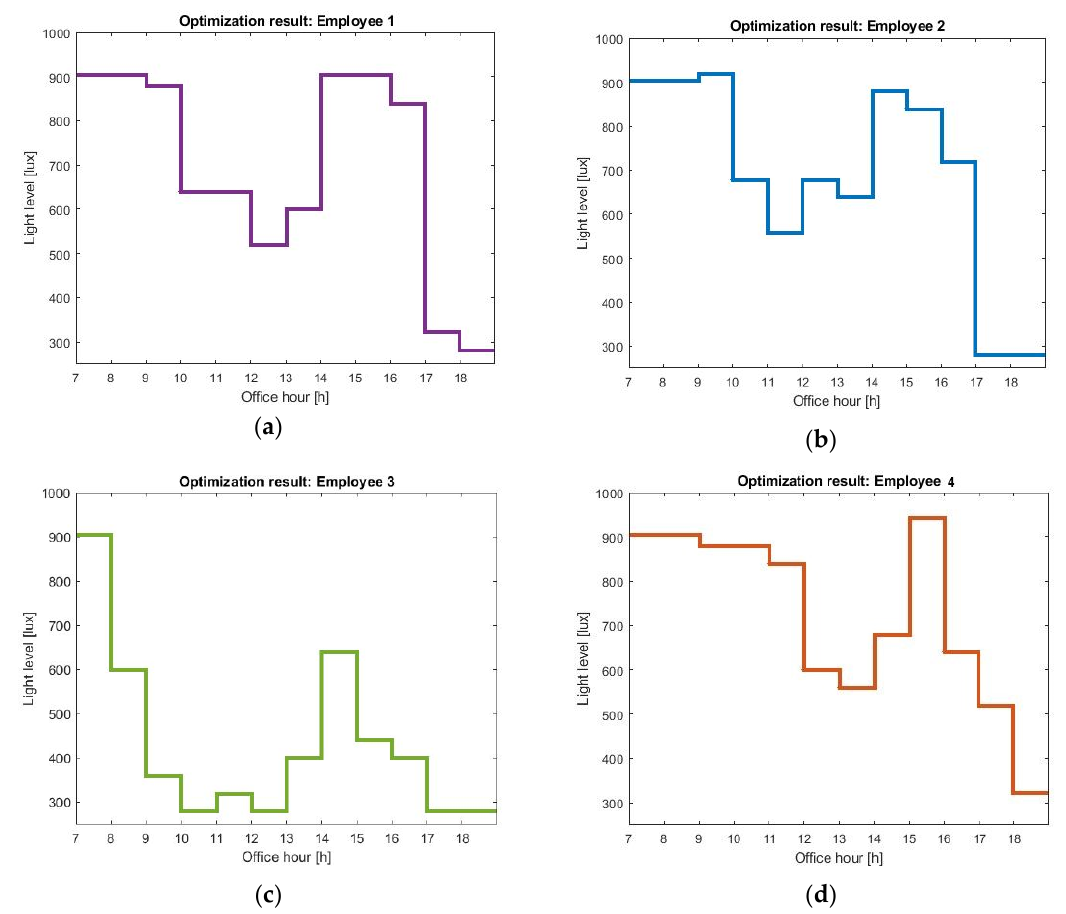
Figure 5. Optimal lighting schedules during office hours to shift the employees wake-up time.